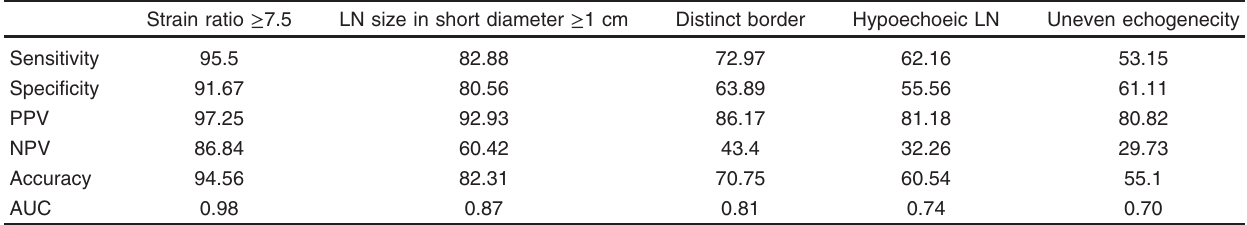
AUC, area under the curve; LN, lymph node; NPV, negative predictive value; PPV, positive predictive